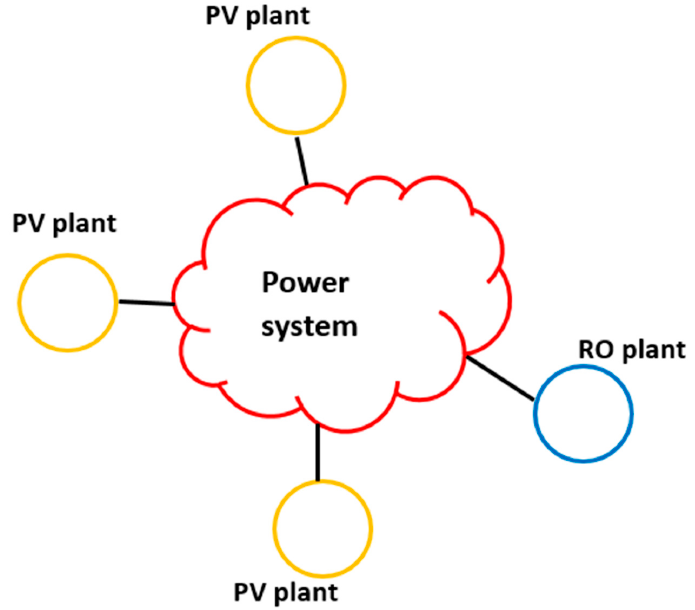
Figure 1. The overall system